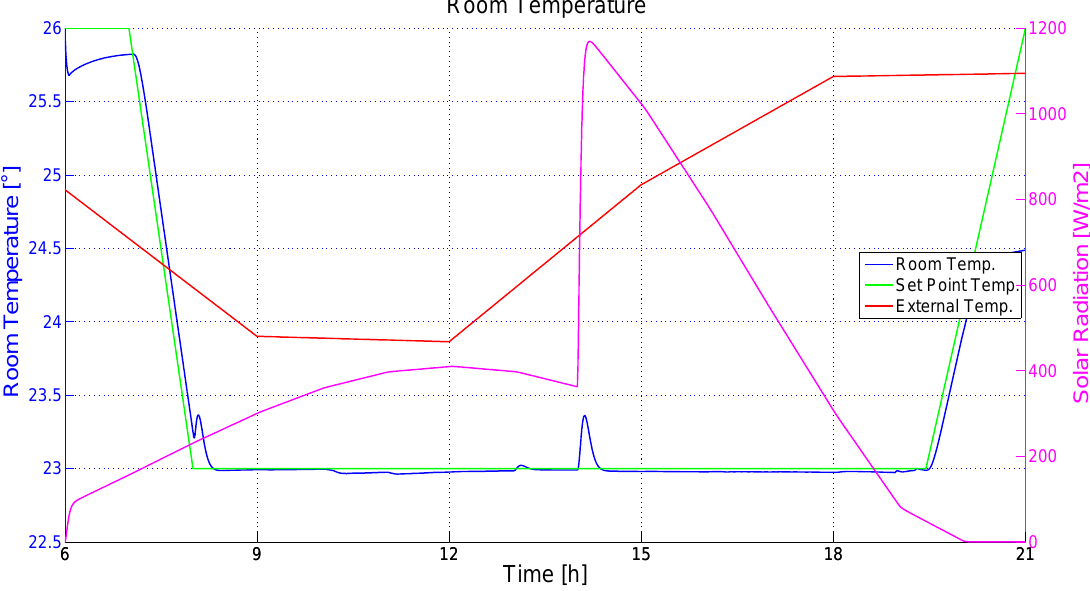
Figure 36. Control results (third scenario, modified control system, Comfort policy): room temperature (CV), outside temperature, and solar radiation (DVs).